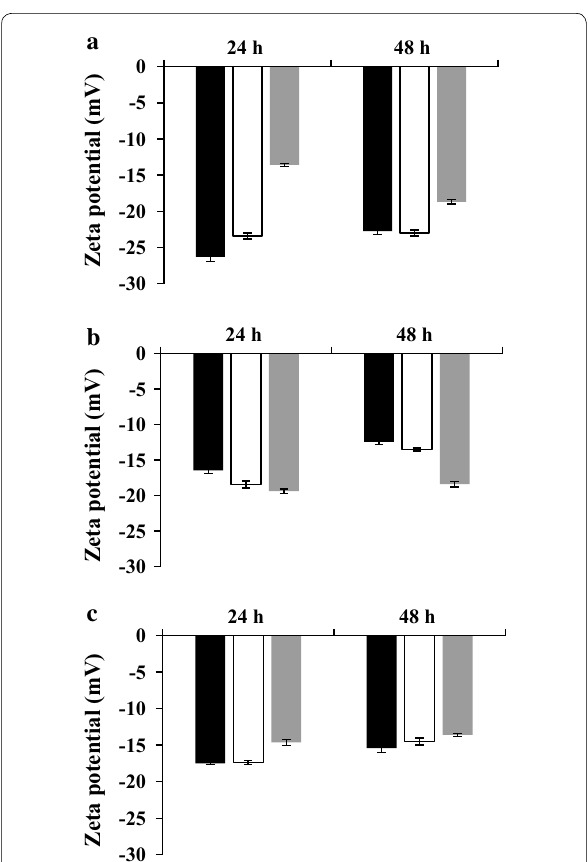
Fig. 1 Zeta potential of planktonic and biofilm detached Staphylo- coccus aureus cells. Cell cultures were grown at 20 °C (black square), 30 °C (white square) and 37 °C (grey square), for 24 and 48 h. Plank‑ tonic cells ( a ), cells detached from biofilm grown on polycarbonate ( b ), cells detached from biofilms grown on stainless steel ( c